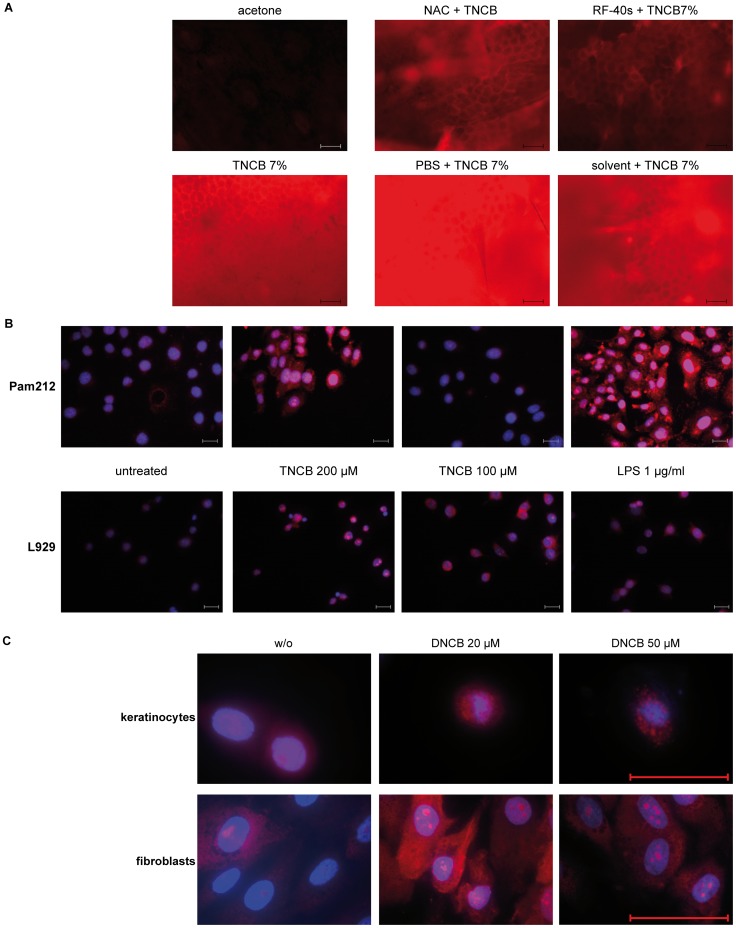
Contact sensitizers induce ROS production in vivo and in mitochondria in vitro.
(A) Mice were pre-treated by topical application of antioxidants (NAC 5 mM or PBS as solvent, RF-40s 5.24 mM or solvent) on the ears. NAC/PBS was applied 1 h before and RF-40s/solvent 15 min before induction of ROS production by topical application of TNCB (7%). Acetone treatment served as solvent control for TNCB. 15 min later, ears were taken after euthanasia and incubated ex vivo with DHE (5 mM) in DMSO for 30 min before analysis of ROS production by fluorescence microscopy. Fluorescence was set for minimal background staining with the acetone control to optimize visualization of differences in ROS production in the other samples. Same acquisition times were used for all samples of one experiment. Results shown are representative of three independent experiments. Magnification  = 200×, scale bar  = 50 µm. (B) Pam212 or L929 cells were incubated with TNCB, LPS or left untreated for 1 h before addition of MitoSOX™. ROS production was observed by red/orange fluorescence of MitoSOX™ by fluorescence microscopy. Nuclei were visualized by DAPI staining (blue). Pictures shown are representative of three independent experiments. Magnification  = 400×, scale bar  = 20 µm. (C) Primary human fibroblasts or keratinocytes were incubated with DNCB or left untreated for 1 h before addition of MitoSOX™. ROS production was observed by red/orange fluorescence of MitoSOX™ by fluorescence microscopy. Pictures shown are representative of three independent experiments. Magnification  = 1000×, scale bar  = 50 µm.